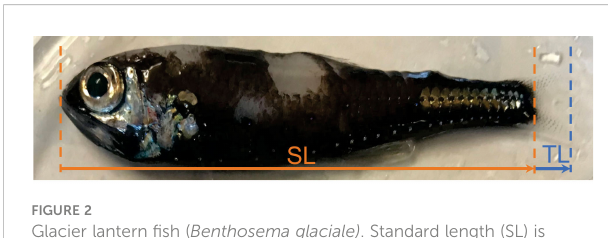
FIGURE 2 Glacier lantern fi sh ( Benthosema glaciale) . Standard length (SL) is measured from the tip of the snout to the tail root (orange arrow). If total length (TL) is measured the caudal fi n (blue arrow) is included. Photo: Espen